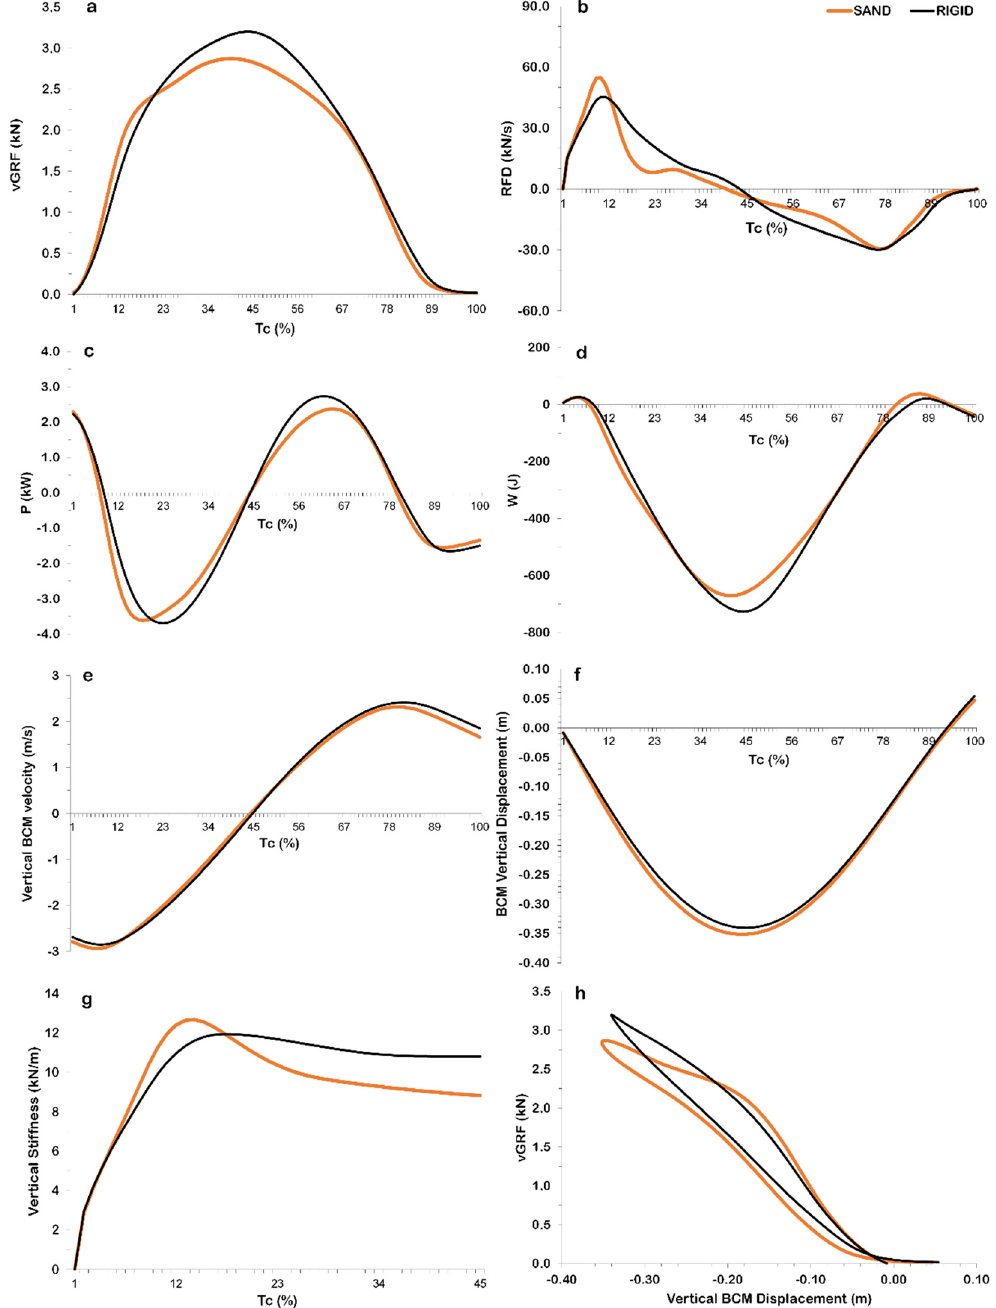
Figure 2. Mean ensemble ( n = 16) time − history curves for the examined drop jump kinetic parameters on rigid (RIGID) and sand (SAND) surface: ( a ) vertical ground reaction force; ( b ) rate of force development; ( c ) power; ( d ) work; ( e ) body center of mass vertical velocity; ( f ) body center of mass vertical displacement (0 = body center of mass height at the instant of touchdown); ( g ) vertical stiffness; ( h ) vertical stiffness depicted by plotting the vertical body center of mass displacement vs. the vertical ground reaction force. Abbreviations: vGRF: vertical Ground Reaction Force; RFD: Rate of Force Development; P: power; W: work; BCM: body center of mass; Tc: contact time. NOTE: all curves are normalized with respect to Tc; the curves in Figure 2h are depicted for the time period from touchdown to the lowest height of the BCM during the contact with the surface.